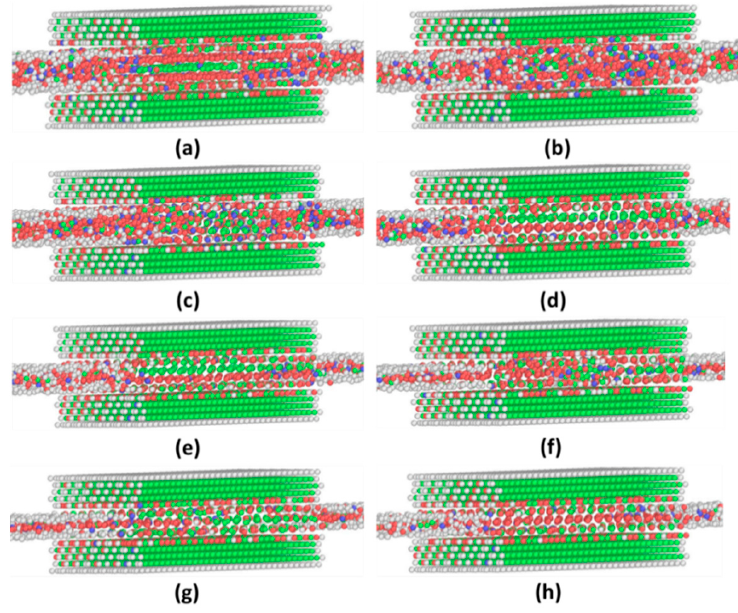
Figure A2. The equilibrium configurations of argon molecules confined between two incommensurate contacts observed in LVMD simulations with varying thicknesses: ( a ) 18.5 Å, ( b ) 17.5 Å, ( c ) 17.0 Å, ( d ) 16.0 Å, ( e ) 15.0 Å, ( f ) 14.0 Å, ( g ) 13.0 Å, and ( h ) 12.5 Å. Only central walls are shown. They are consistent with those observed in GCMC/MD simulations with chemical potential μ = − 2.28 kcal/mol as shown in Figure 10.